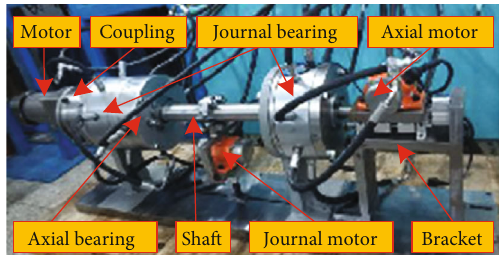
Figure 1: Overall view of MLDSB.